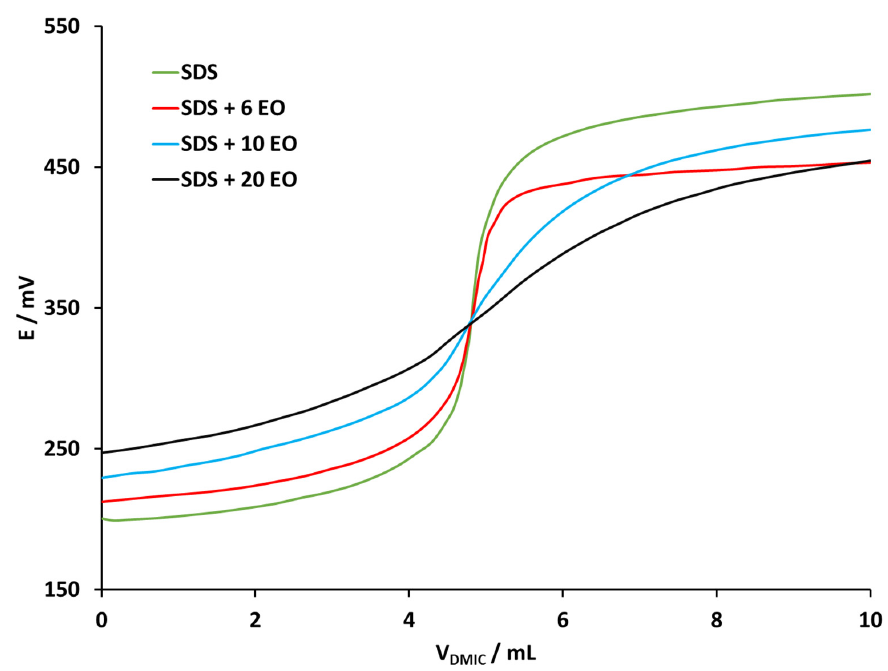
Figure 5. Potentiometric titration curves for titration of the mixture of SDS (4 × 10 − 3 M) and EONS with a different number of EO groups at fixed DS: EONS molar ratio (1:2) with the DMIC (4 × 10 − 3 M) as a titrant and a DHBI–TPB surfactant sensor as an end-point indicator. The titration curves are rearranged for the sake of clarity in the following order: only SDS (green line), SDS with 6 EO groups (red line), SDS with 10 EO groups (blue line), SDS with 20 EO groups (black line).